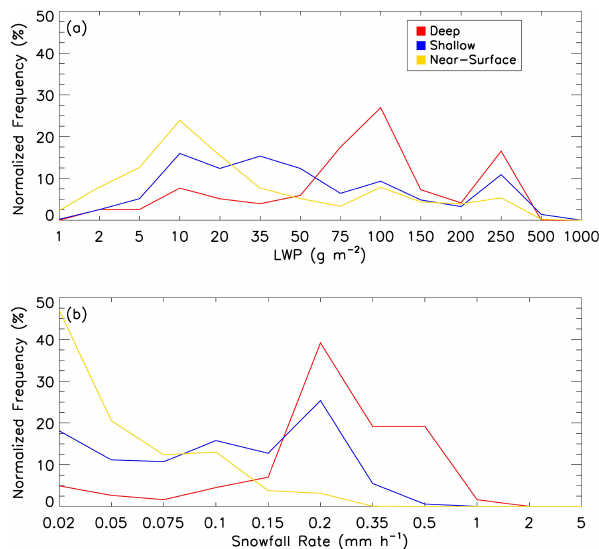
Figure 6. Frequency distribution of (a) the liquid water path and (b) the snowfall rate at the surface level derived from all observed snowfall data during the 2017–2018 winter. The frequency values are normalized so that the sum of their values at all bins is 100%.